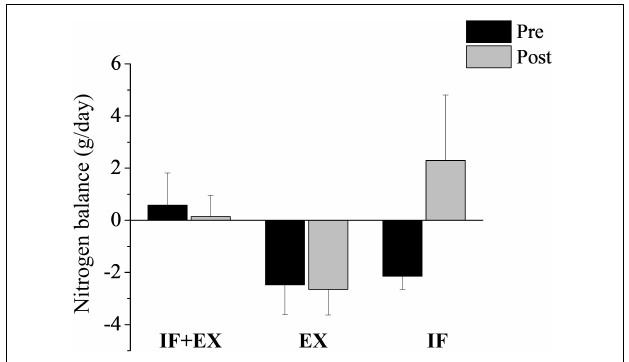
FIGURE 4 | Nitrogen balance (g/day) pre- and post-intervention. IF + EX, intermittent fasting group in conjunction with exercise ( n = 14); EX, exercise group ( n = 11); IF, intermittent fasting group ( n = 7). Values expressed as mean ± standard error. *Difference within the group, post vs pre, by ANOVA two-way mixed repeated measure, Sidak post hoc , and Welch’s correction.